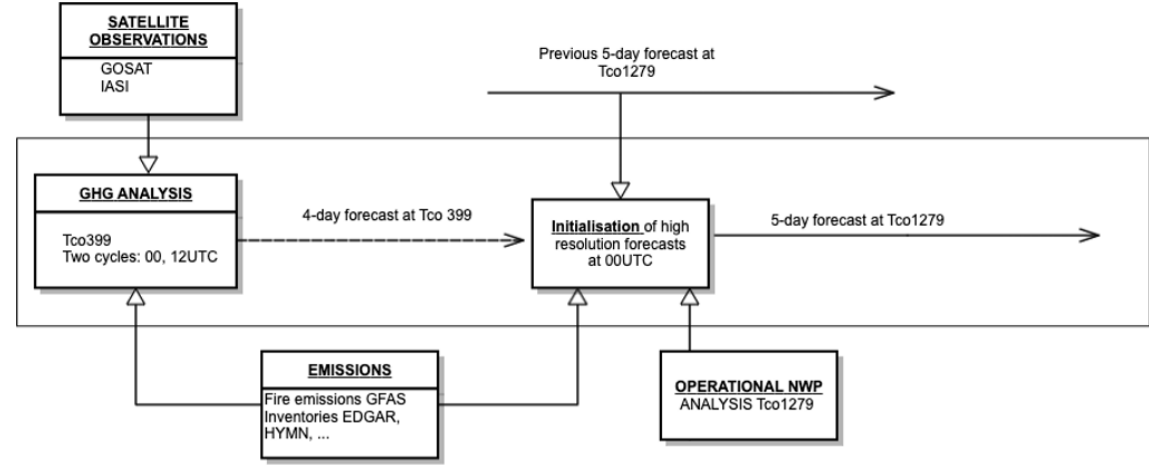
Figure 3. Flow chart of the CAMS greenhouse gas analysis and forecast system.